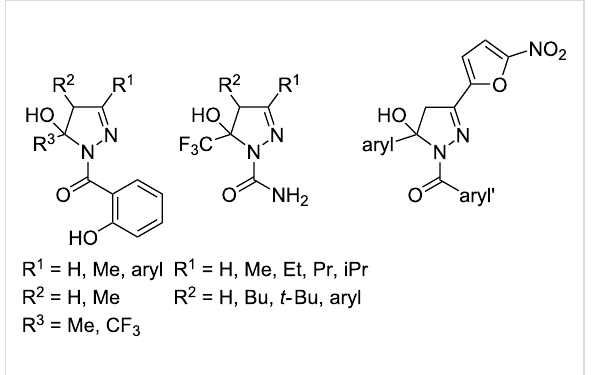
Figure 2: Selected 1-acyl-5-hydroxypyrazolines with analgesic (left, center) and antibacterial activity (center and right).